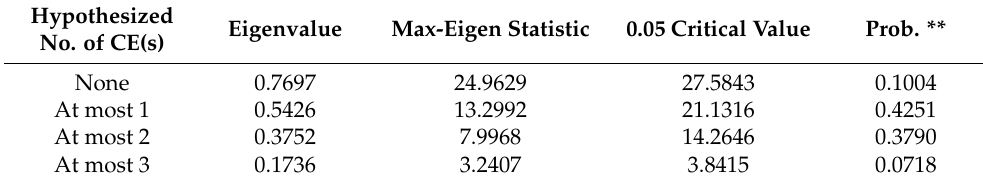
Table 5. Unrestricted Cointegration Rank Test (Maximum Eigenvalue).